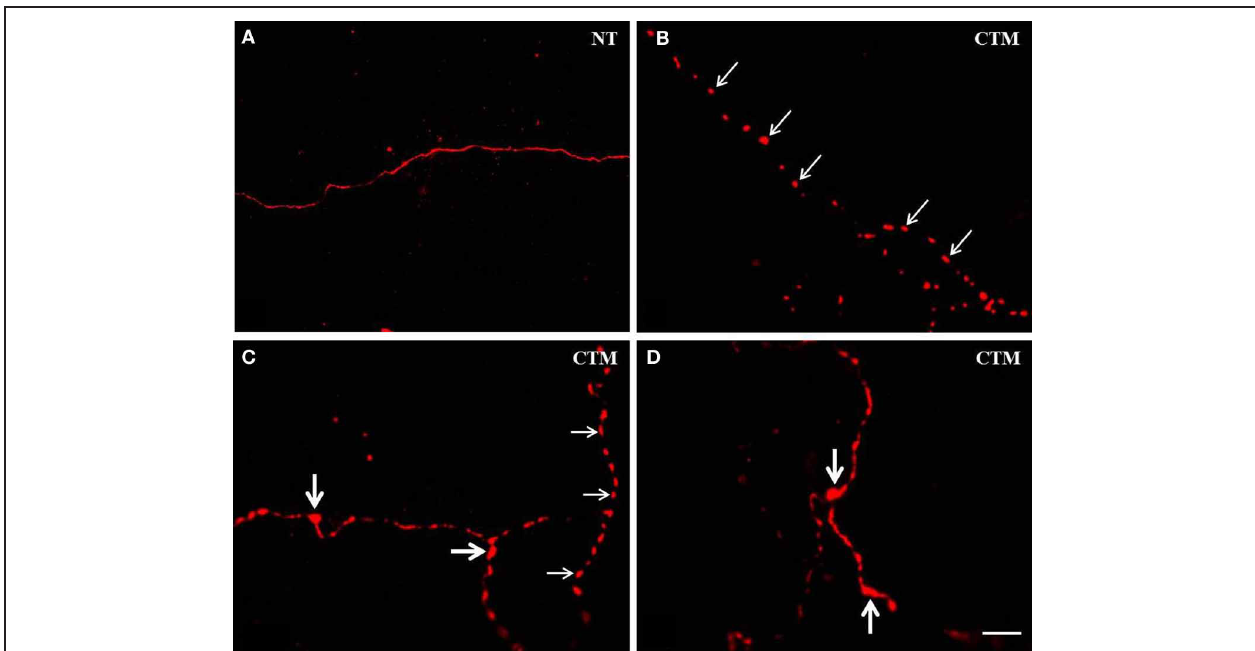
(C,D) The SERT-ir fibers with large bouton-like appearance (thick arrows) were noted in CTM exposed male rats. Scale bar = 2 μ m. NT, non-treatment; CTM, citalopram; OB, olfactory bulb; SERT, serotonin